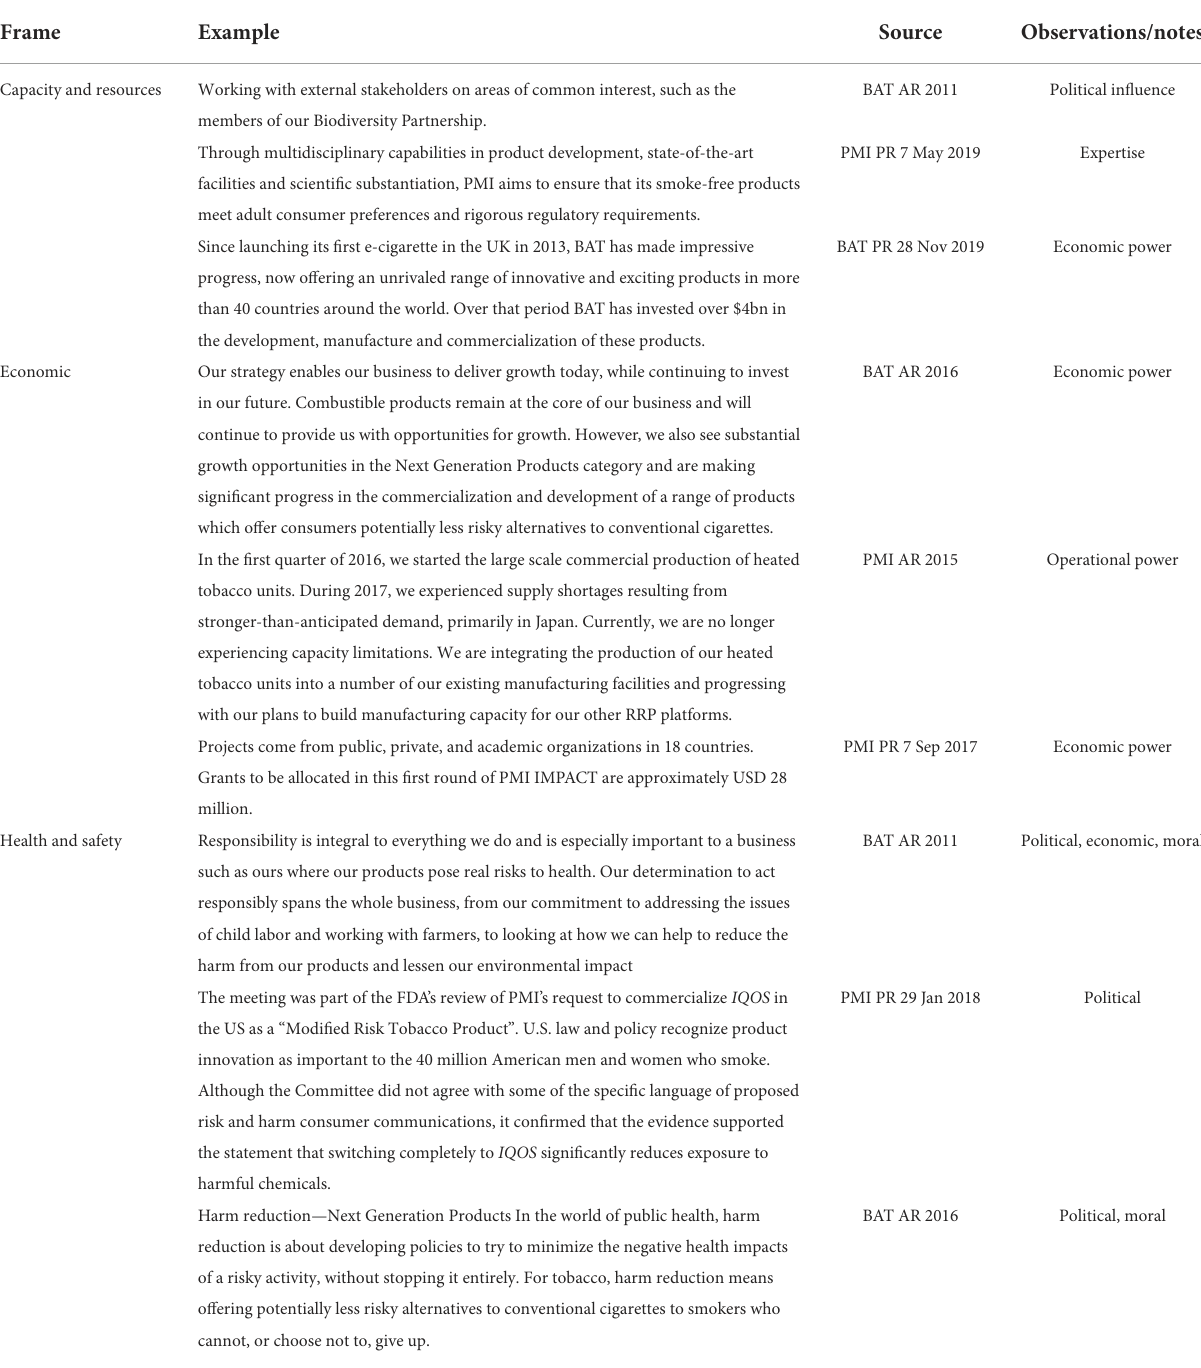
TABLE 3 Example content from the three most common